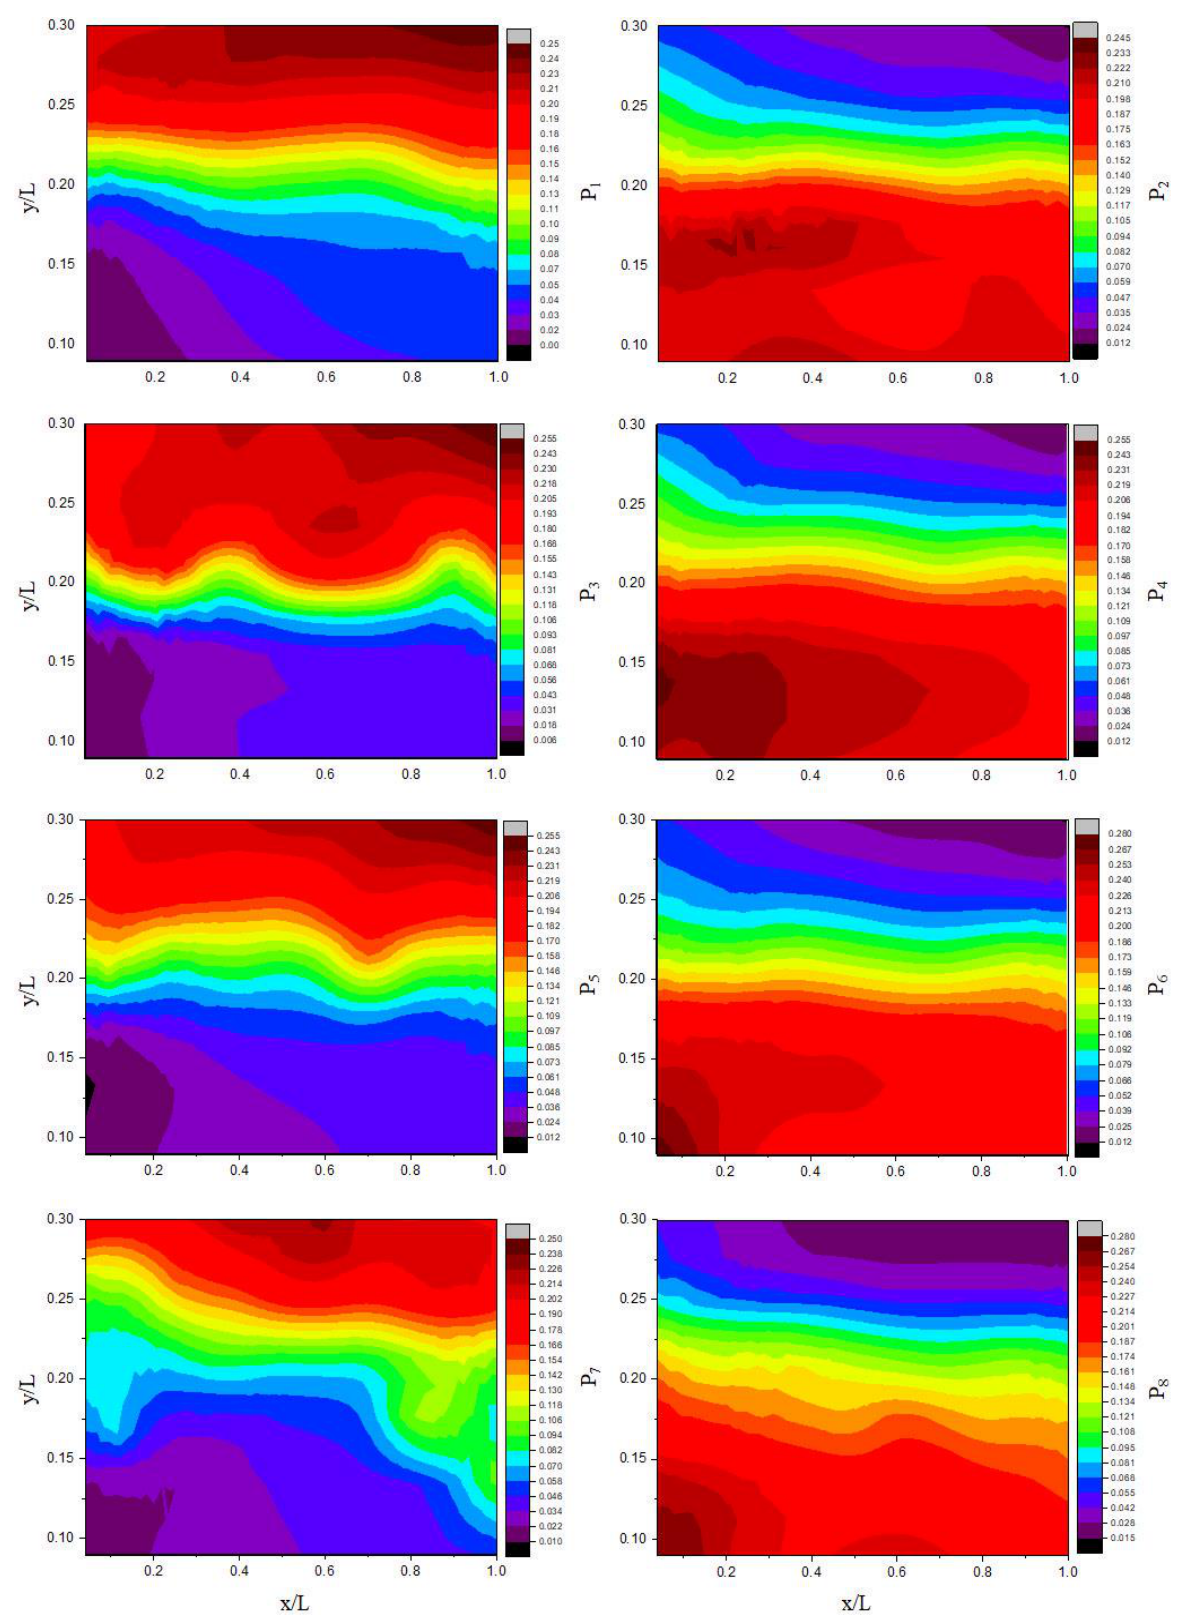
Figure 11. Contours maps of depth-averaged occurrence probability of octagonal bursting events (P 1 – P 8 ) for the experimental run 10R.